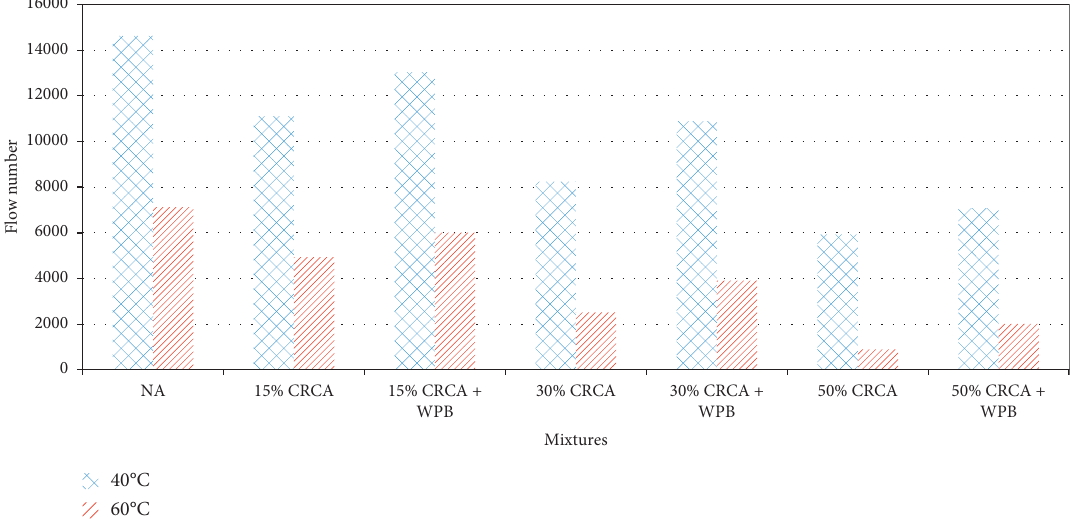
Figure 6: Flow number of modified and controlled asphalt concretes at two